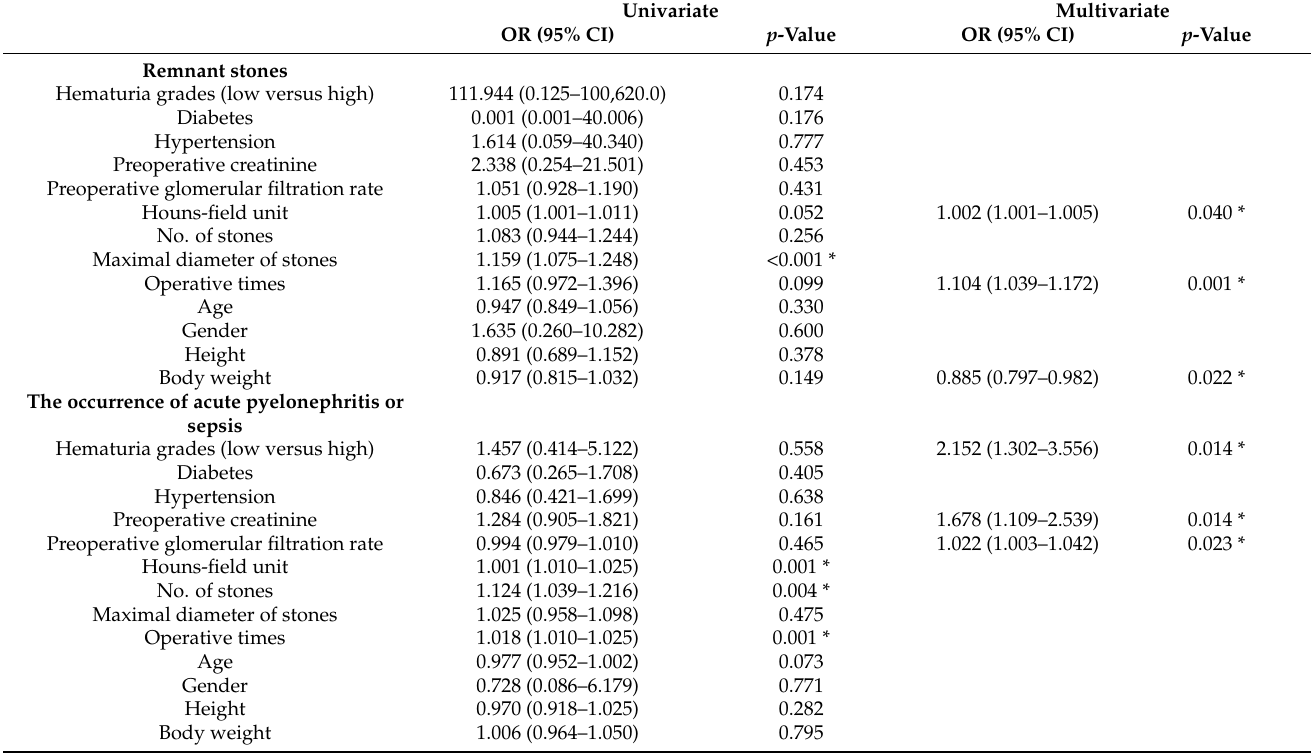
Table 4. Logistic regression analysis for prediction of remnant stones and the occurrence of acute pyelonephritis or sepsis in the development group of RIRS.